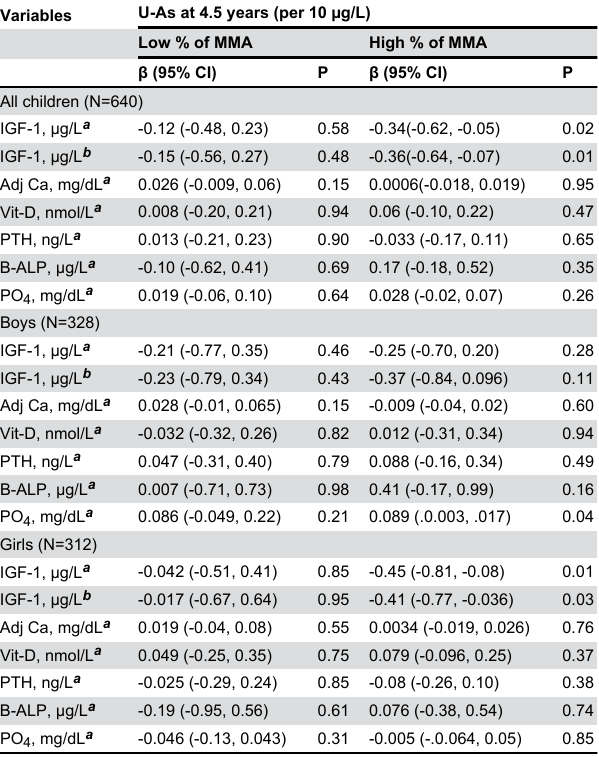
Table 6. Linear regression analysis of plasma biomarkers in relation to concurrent arsenic exposure in 4.5 years old children, boys and girls stratified by % of MMA (median split,